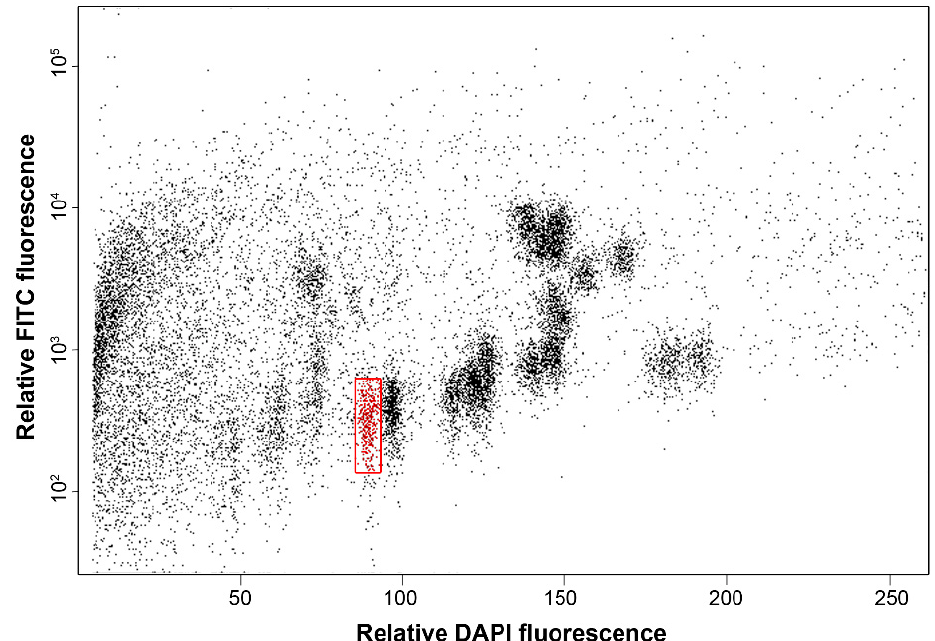
Figure 1. Bivariate flow karyotype FITC vs. DAPI fluorescence obtained after the analysis of chromosomes isolated from the Triticale 380SD line. The population representing chromosome arm 7RS was clearly discriminated and this allowed its sorting using window shown as red rectangle.